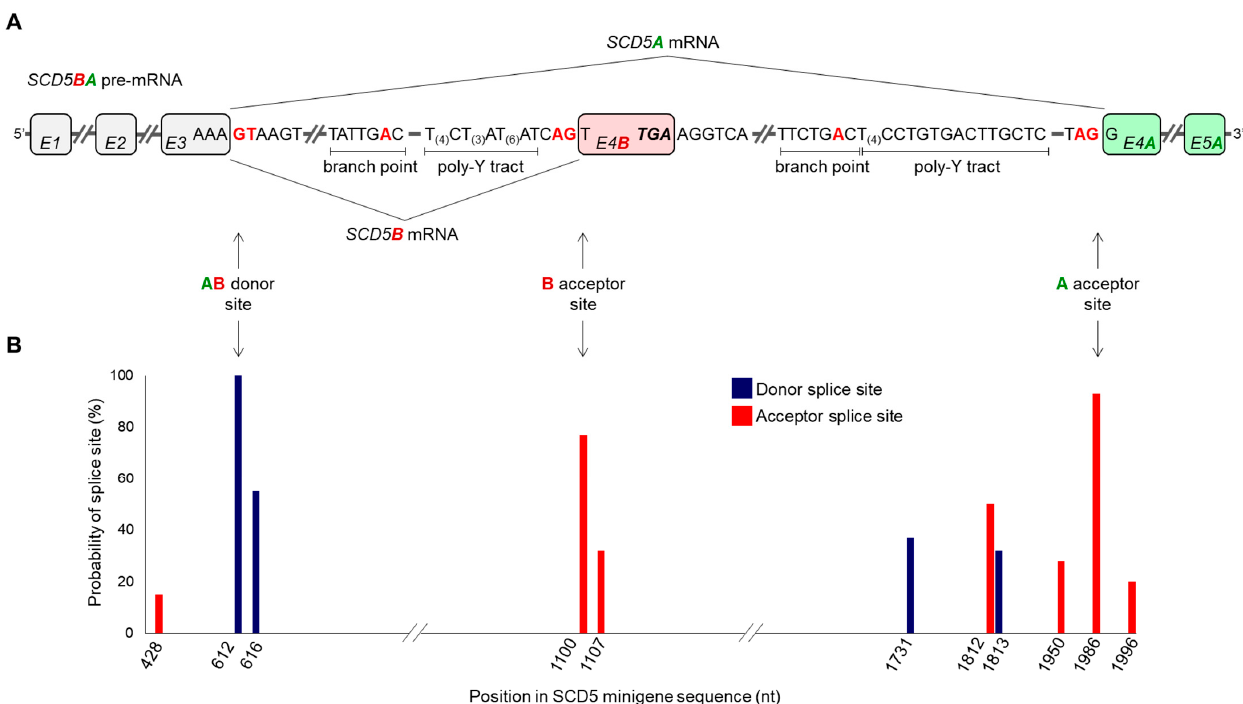
Figure 3. SCD5A - and SCD5B -specific splice site analysis in silico. ( A ) Schematic representation of SCD5 pre-mRNA. The splice sites, branch points and poly-Y tracts harboring sequences required for the formation of the alternative terminator of SCD5 are presented. SCD5A - and SCD5B -specific and shared exons are shown in green, red and gray, respectively. Core nucleotides of the splice sites are marked in red. Possible AS events are indicated by arrows. ( B ) Probabilities of AB donor site and A and B acceptor sites were predicted by NetGene2-2.42, as indicated in Section 4 and plotted over the position in SCD5 minigene sequence. (nt: nucleotide; poly-Y tract: poly-pyrimidine tract).